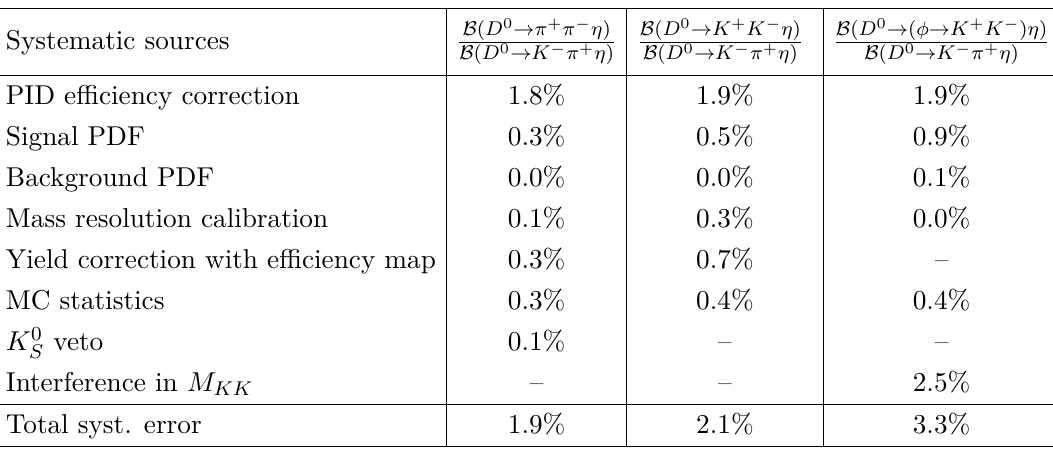
Table 2 . Systematic uncertainties (fractional) for the branching ratio